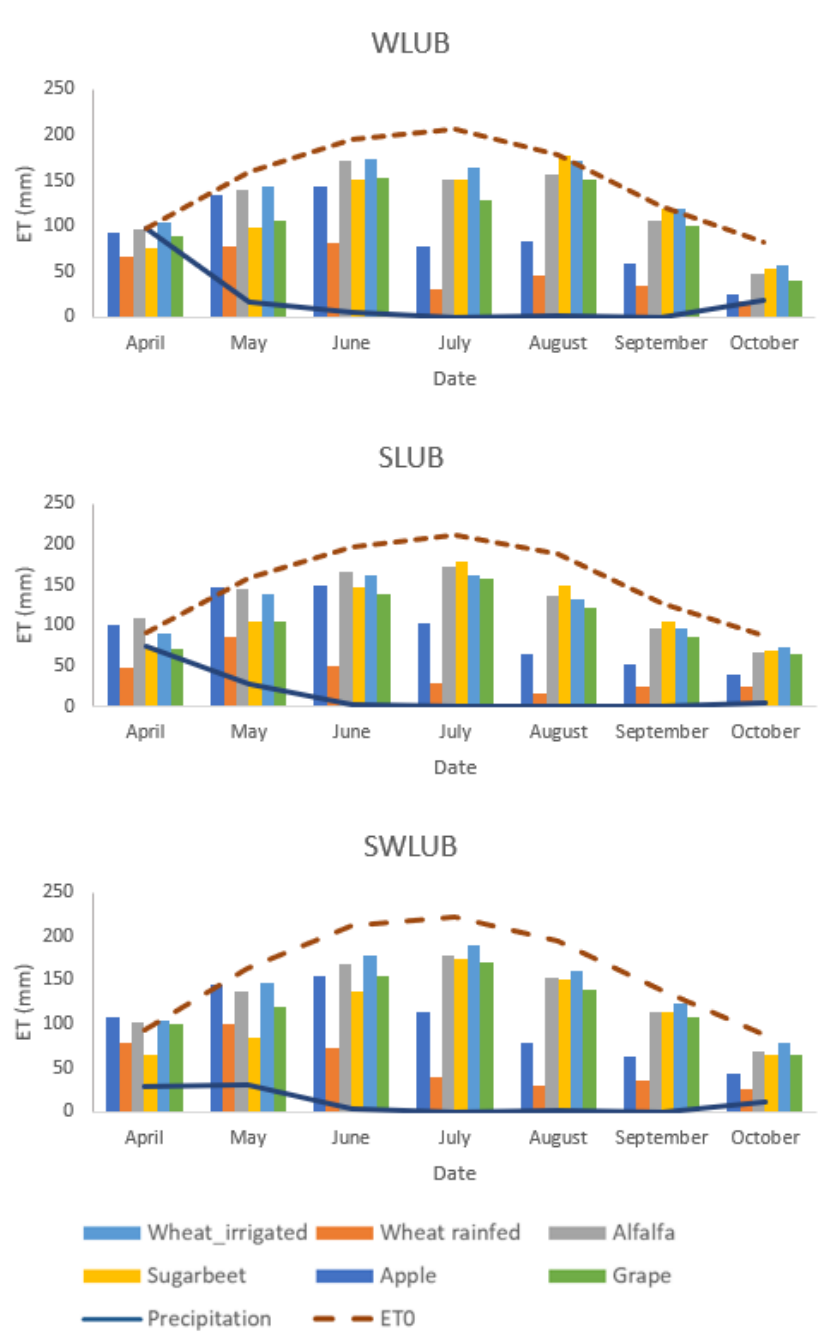
Figure 6. Monthly precipitation, reference ET, and actual ET for each individual crop in major agricultural districts in LUB.